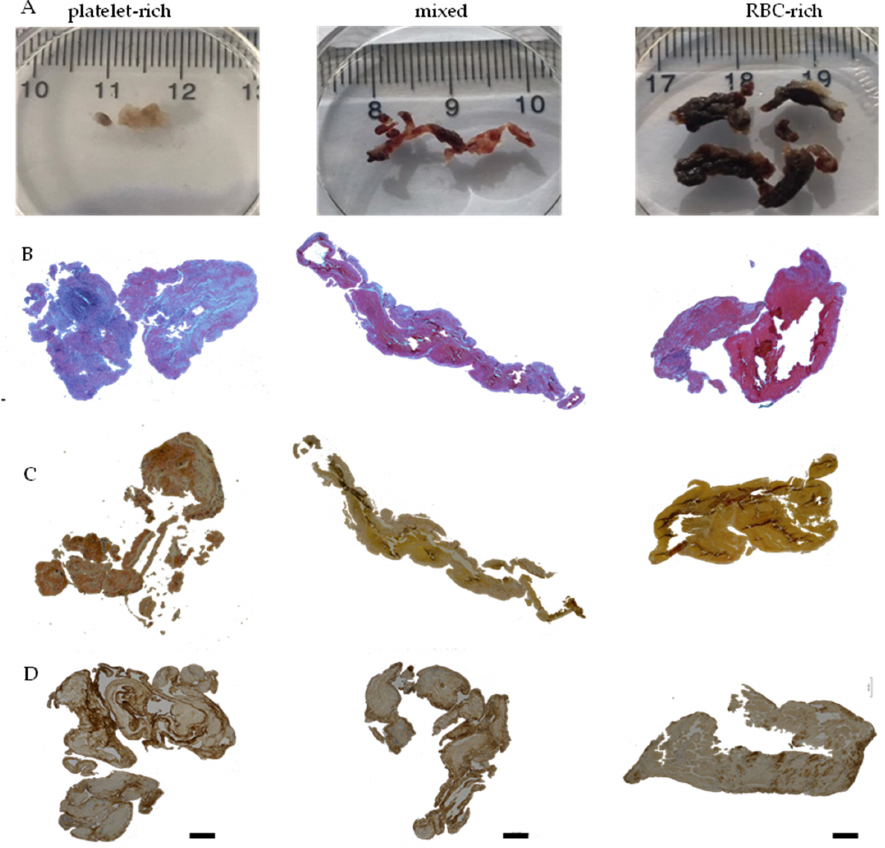
Figure 2. Distinct red blood cell (RBC)-rich and platelet-rich areas are seen in stroke thrombi. ( A ) Representative photomacrographs of the platelet-rich, mixed, and RBC-rich thrombi were retrieved from ischemic stroke patients. ( B ) Martius Scarlet Blue (MSB) staining of the three representative thrombi sections. Fibrin-rich areas appear red while RBC-rich areas appear yellow. ( C ) Hematoxylin and Eosin (H and E) staining depicting RBC-rich areas (red) and RBC-poor areas (light pink). ( D ) Immunohistochemical staining shows von Willebrand factor (VWF) in the three representative thrombi sections. Scale bars ( B – D ) = 500 μ m.